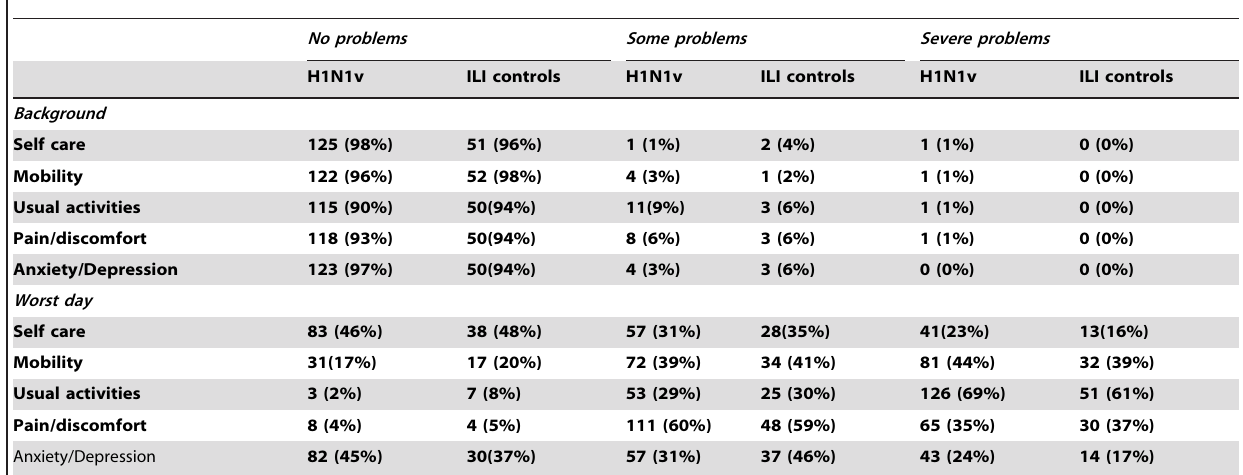
Table 3. Impact on the 5 dimensions as measured in the EQ-5D.